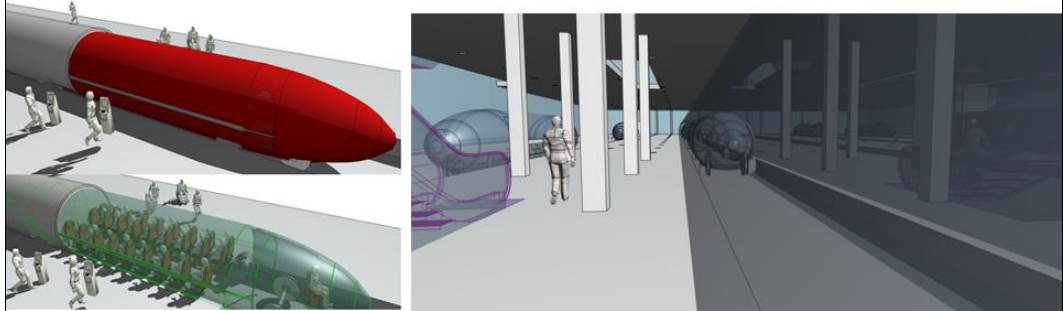
Figure 10. Visualization: how passengers can enter and leave a pod at a platform of a Hyperloop station.